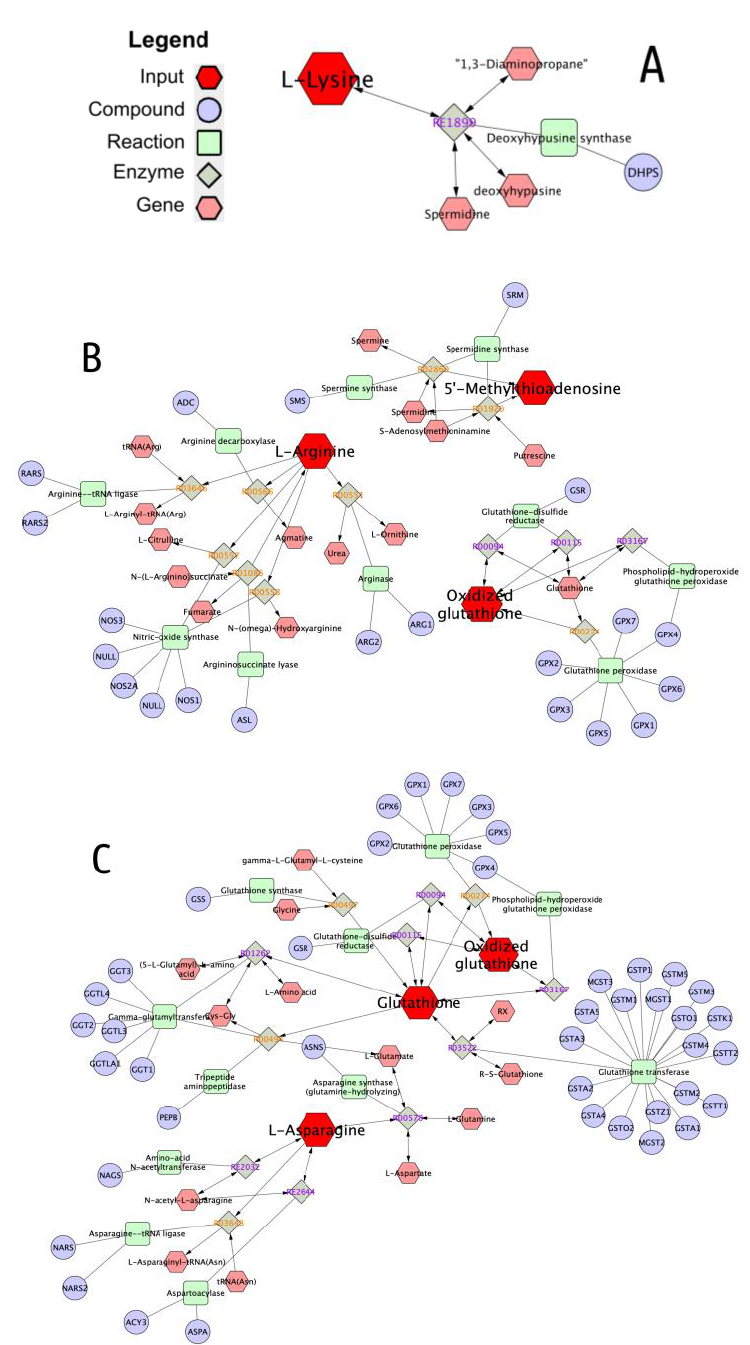
Figure 7. Visual representation generated by MetScape (CREGN) application of the Urea cycle and metabolism of arginine, proline, glutamate, aspartate and asparagine, a common pathway among the three species. Red hexagons symbolize these input MEV metabolites, arrows indicate their connections with other intermediate compounds (pink hexagons) and enzymes (green squares), which might regulate the identified metabolites. Purple circles represent genes encoding those enzymes and beige rhombuses the reactions catalyzed by those enzymes. ( A ) Bovine, ( B ) Donkey, ( C ) Goat.